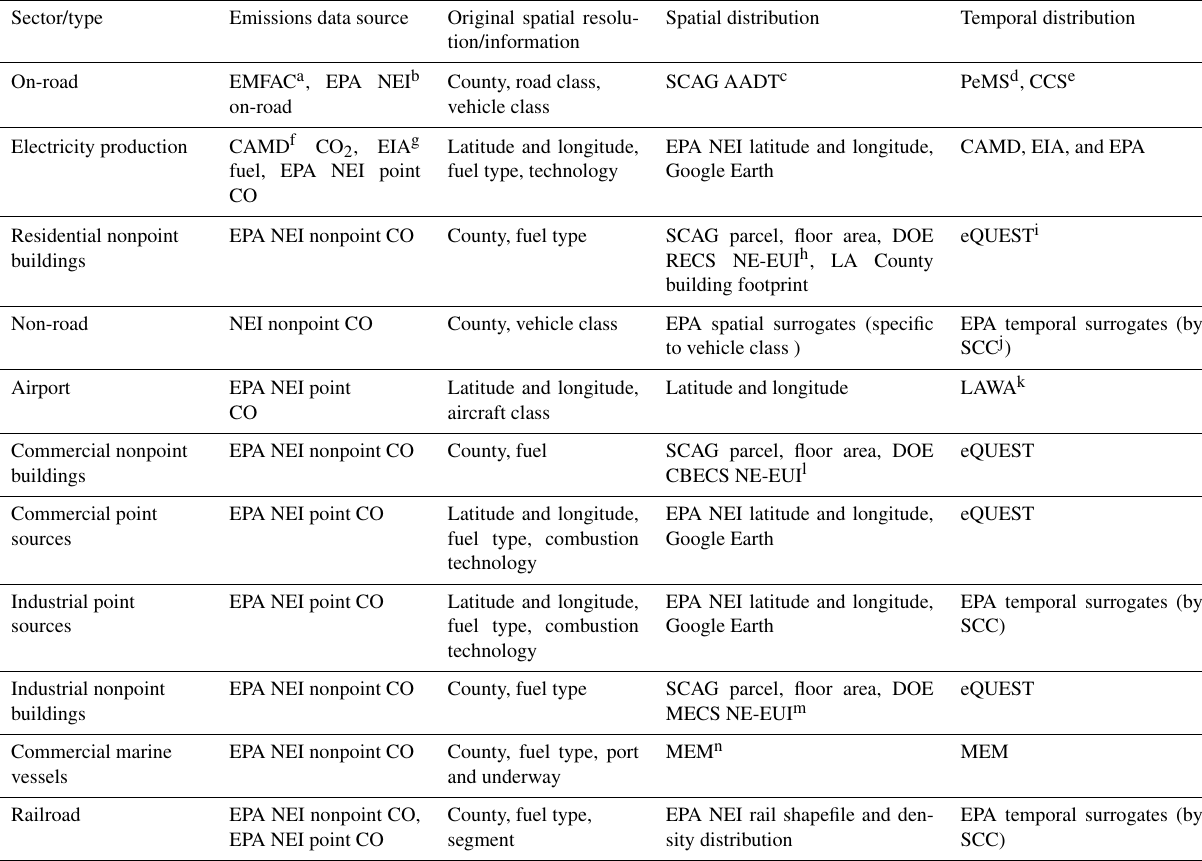
Table 1. Data sources used in the spatiotemporal distribution of FFCO 2 emissions (the text provides acronym explanations and